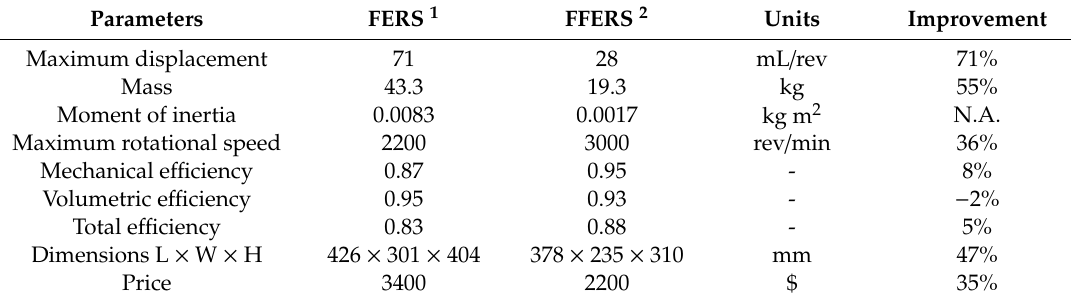
Table 4. Simulation parameters of PMs in FERS and FFERS.